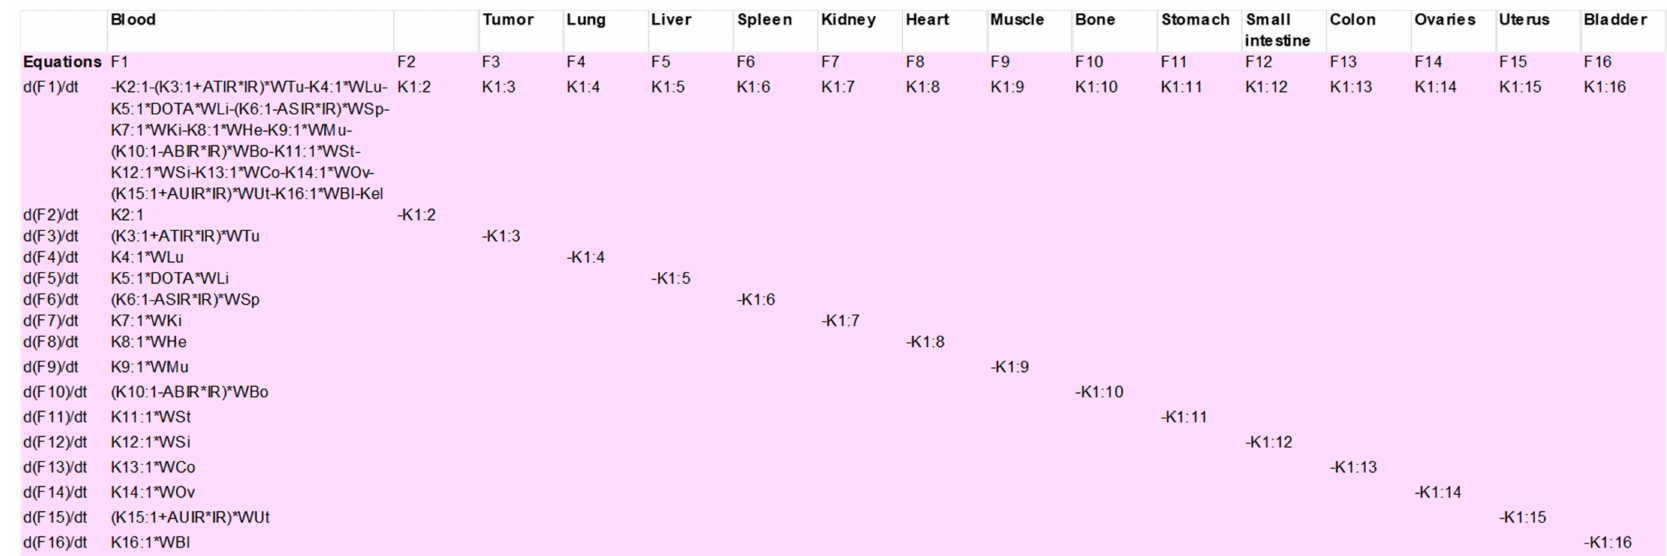
Figure A2. Excel data sheet example of a multi-tissue biodistribution (16 compartments) modeling.